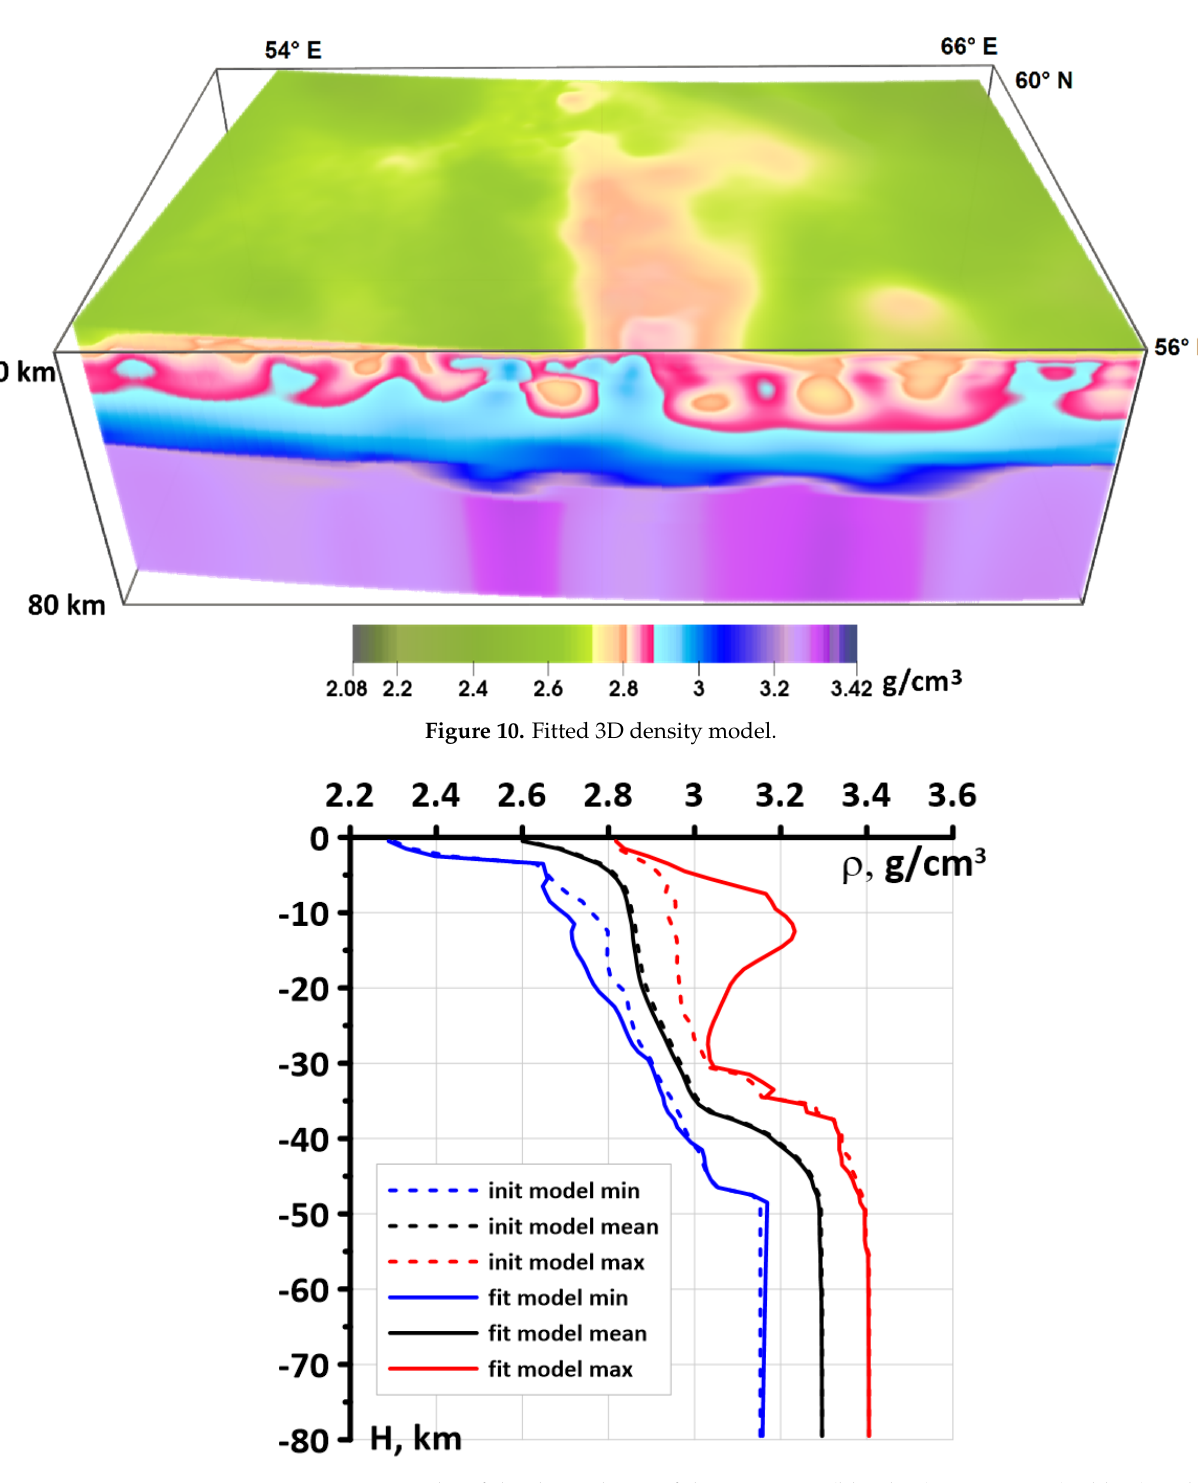
Figure 11. Graphs of the dependence of the minimum (blue line), maximum (red line) and mean (black line) density of the initial (dash line) and fitted (solid line) models on the depth. The stability of the proposed method is demonstrated here. To the observed field (Figure 5-(1)), at a random 33% of all points, we add Gaussian noise with zero mean and standard deviation of 6.72 mGal (33% of the standard deviation of the field). Figure 12 shows the